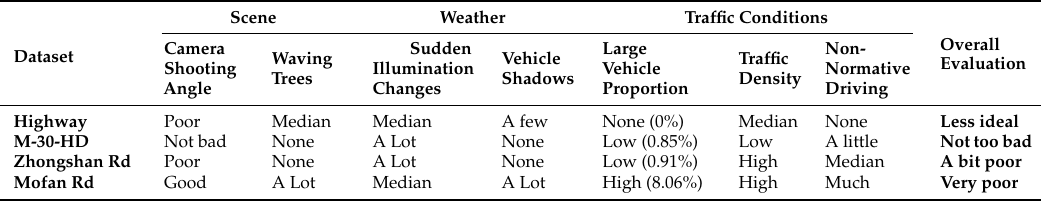
Table 3. The characteristics and challenges of each